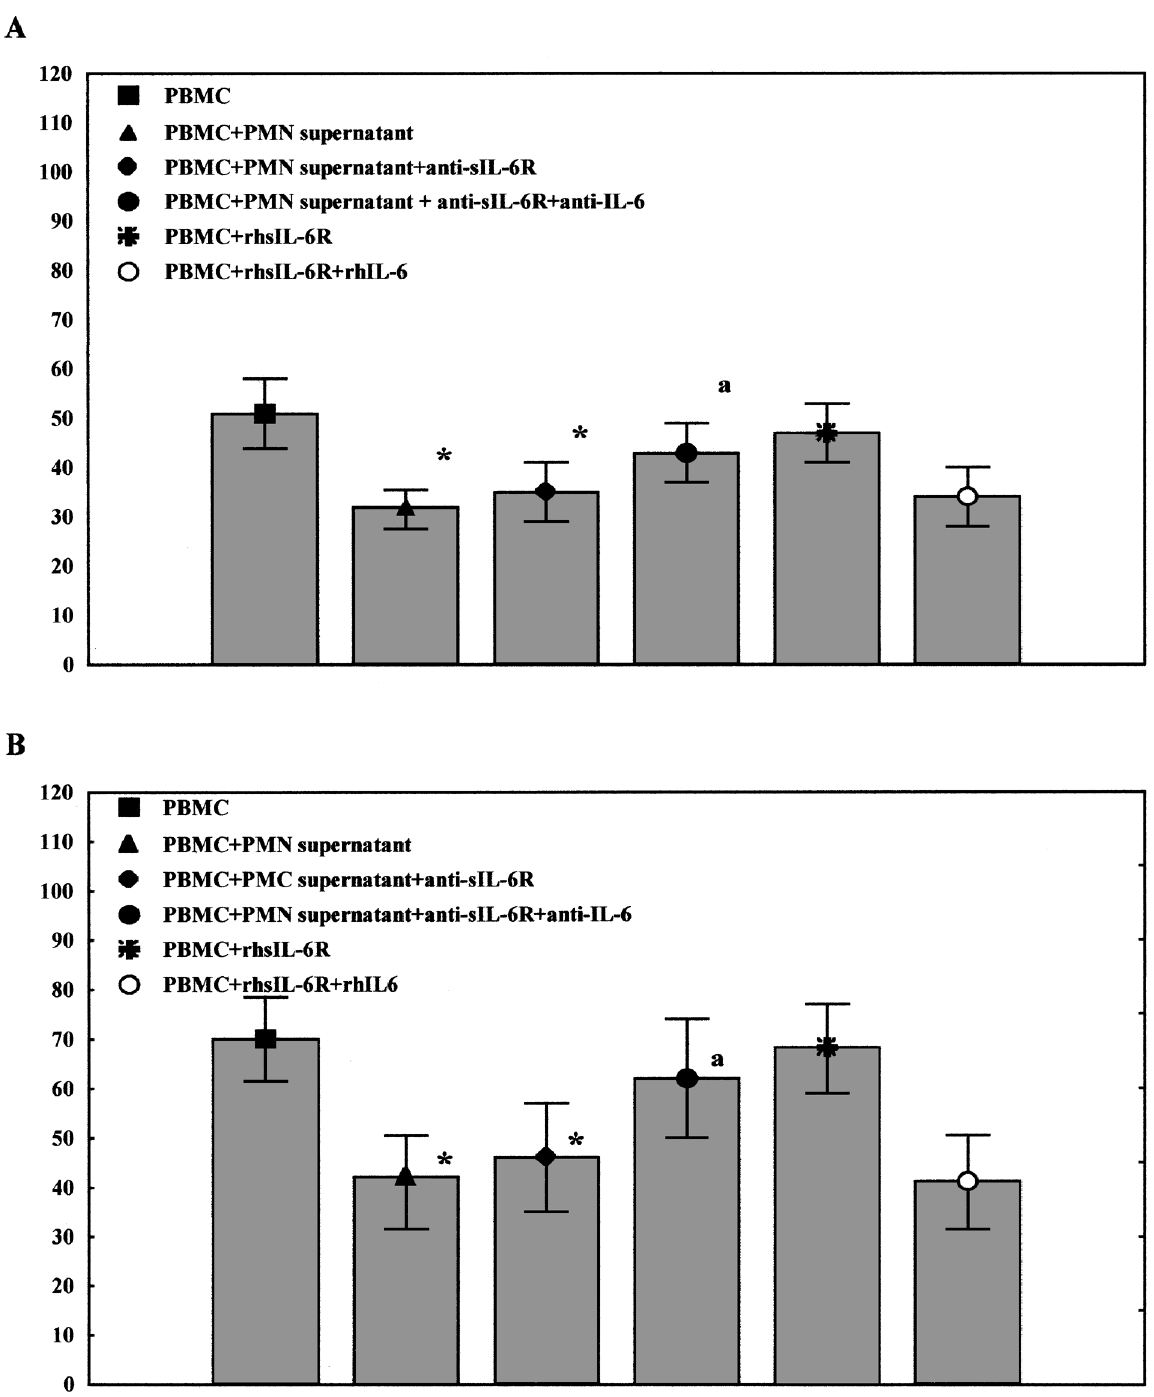
FIG. 1. TNF- a expression and its production by unstimulated and stimulated PBMC. (A) TNF- a mRNA expression ( m mol/ml) and (B) TNF- a concentration in the culture supernatant of PBMC (pg/ml). * Statistical difference with unstimulated PBMC ( p < 0.05), a statistical difference with PBMC cultured with PMN supernatant and anti-sIL-6R and anti-IL-6 ( p <